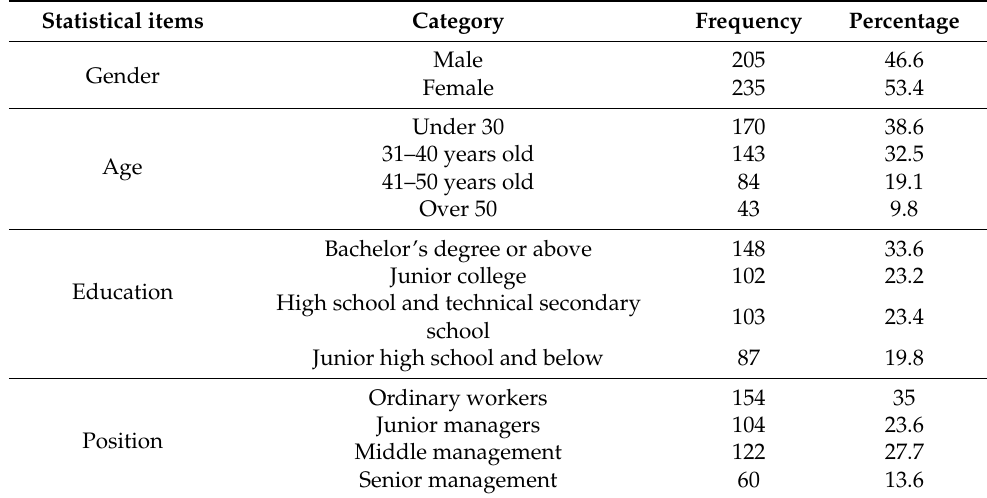
Table 6. Demographic data.